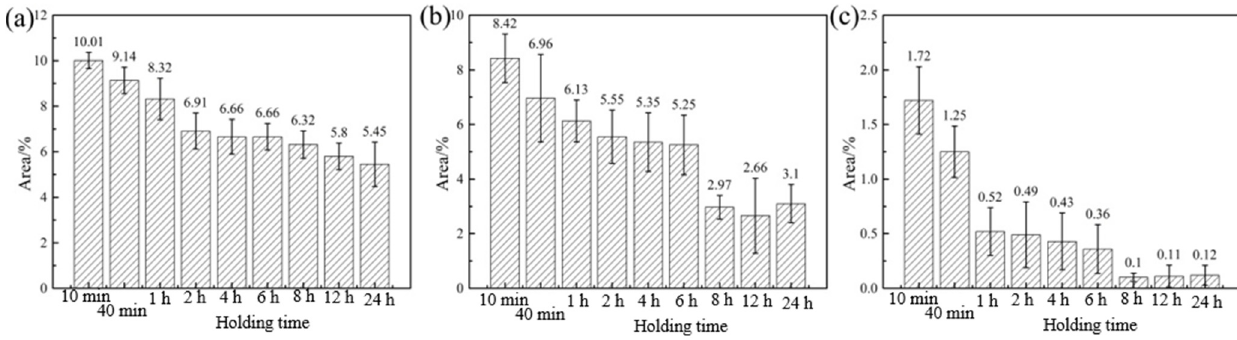
Figure 7. The volume fraction of the second phase against holding time at ( a ) 470 °C, ( b ) 500 °C, and ( c ) 530 °C.